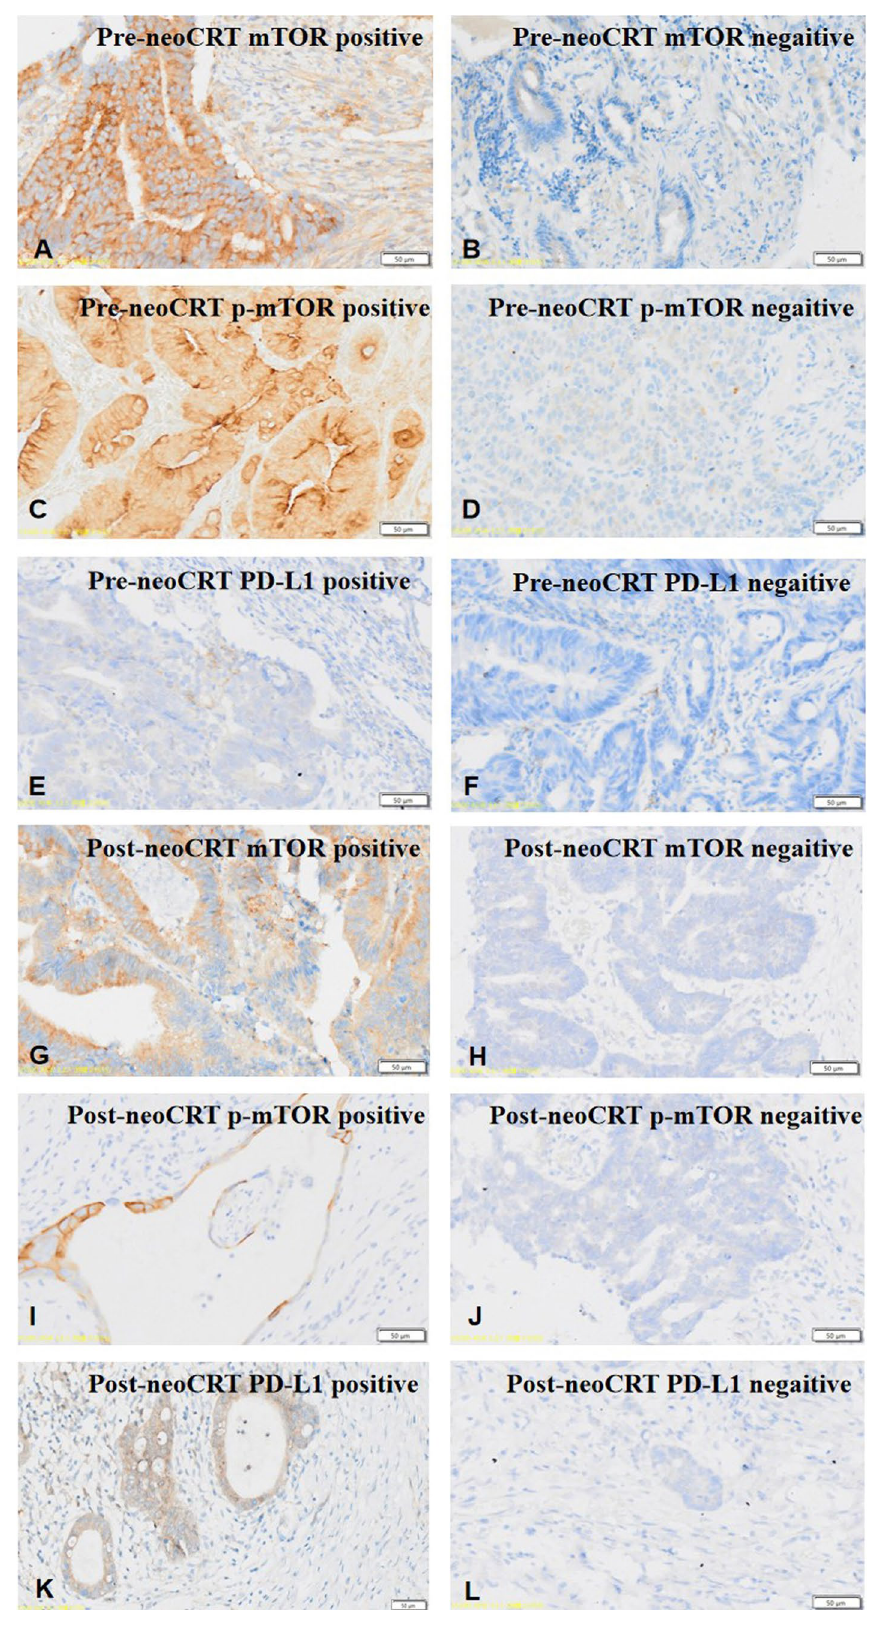
Fig. 1 Representative immu- nohistochemistry staining of mTOR ( A , B , G , H ), p-mTOR ( C , D , I , J ) and programmed death ligand 1 (PD-L1) ( E , F , K , L ) of the pre-neoCRT tissues and post-neoCRT biopsies in locally advanced rectal